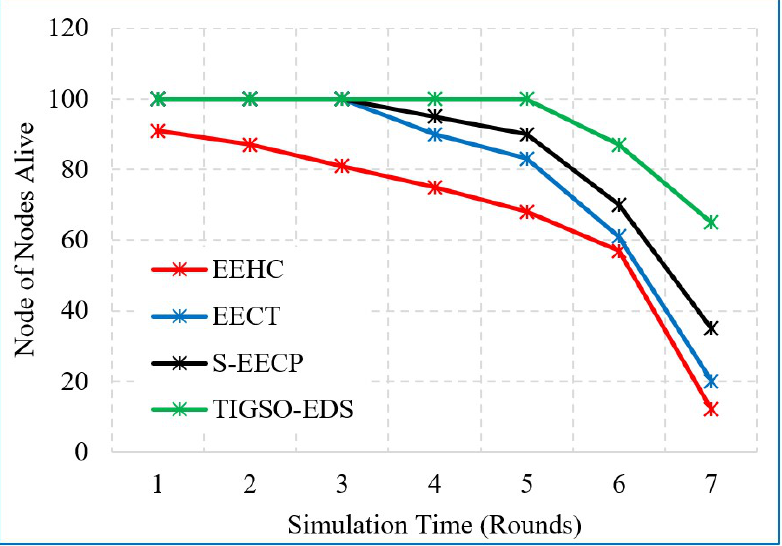
Figure 5. Comparison of alive nodes (base station located at 100 ×